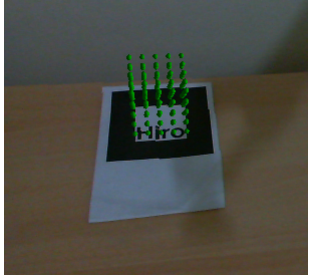
Fig. 7. Particles attached to the movable